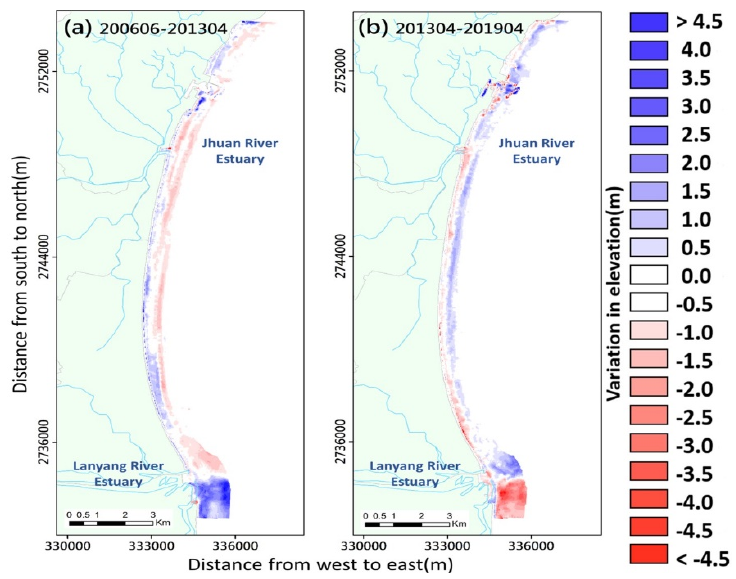
Figure 5. The spatial distribution of erosion and accretion along the shoreline during the periods of ( a ) June 2006 to April 2013 and ( b ) April 2013 to April 2019. ( a ) June 2006 to April 2013 and ( b ) April 2013 to April